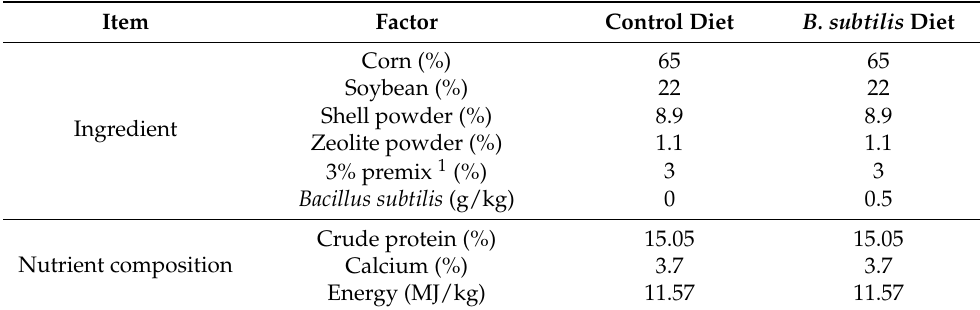
Table 1. Composition of the basal diet for